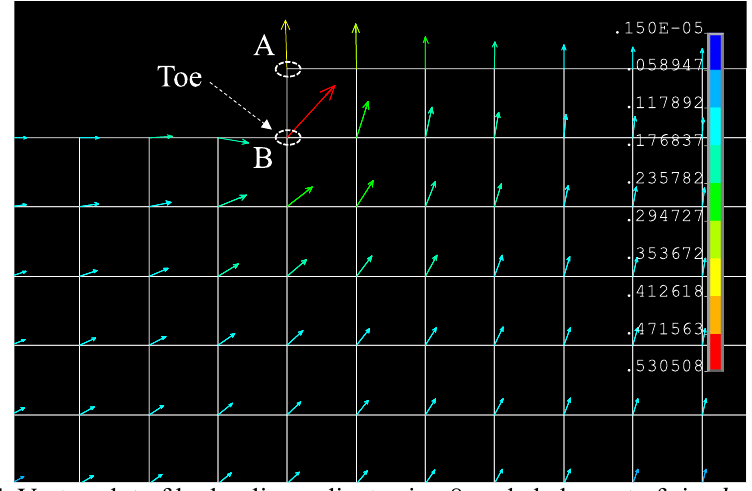
Fig. 4. Vector plot of hydraulic gradient using 8-noded element of size ℎ = 2 𝑚 .